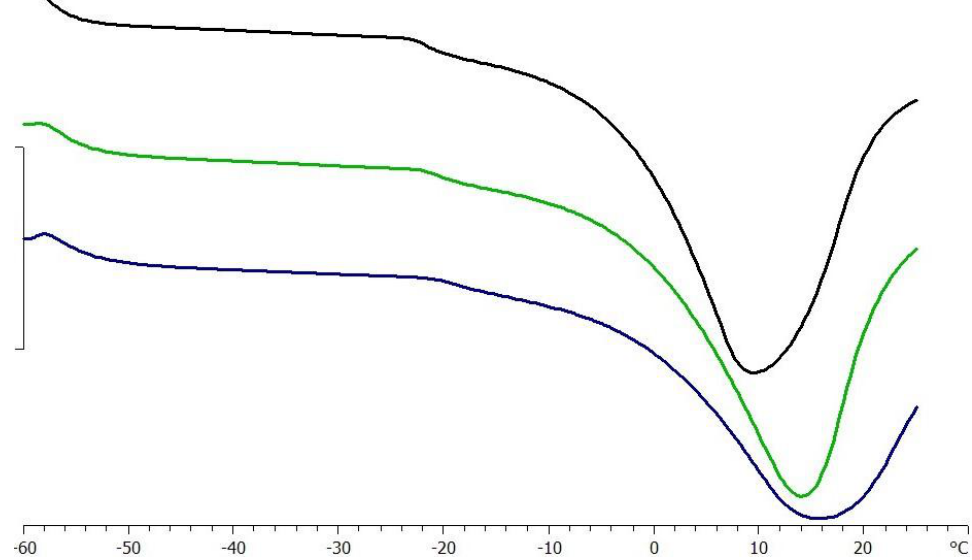
Figure 2. DSC analysis of 40% solution of DS 38 (black line) in the presence of 0.5% Span ® 80 (green line) and 10% IPEC No.1 (blue line).